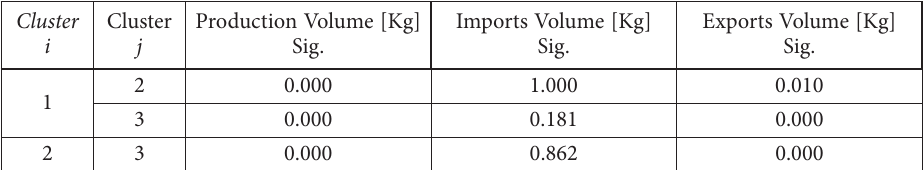
Table 3. Multiple comparisons (Bonferroni) at the first level of pre-crisis clustering (source: own elabo- ration based on COMTRADE, 2018) Cluster Cluster Production Volume [Kg] Imports Volume [Kg] i j Sig. Sig.